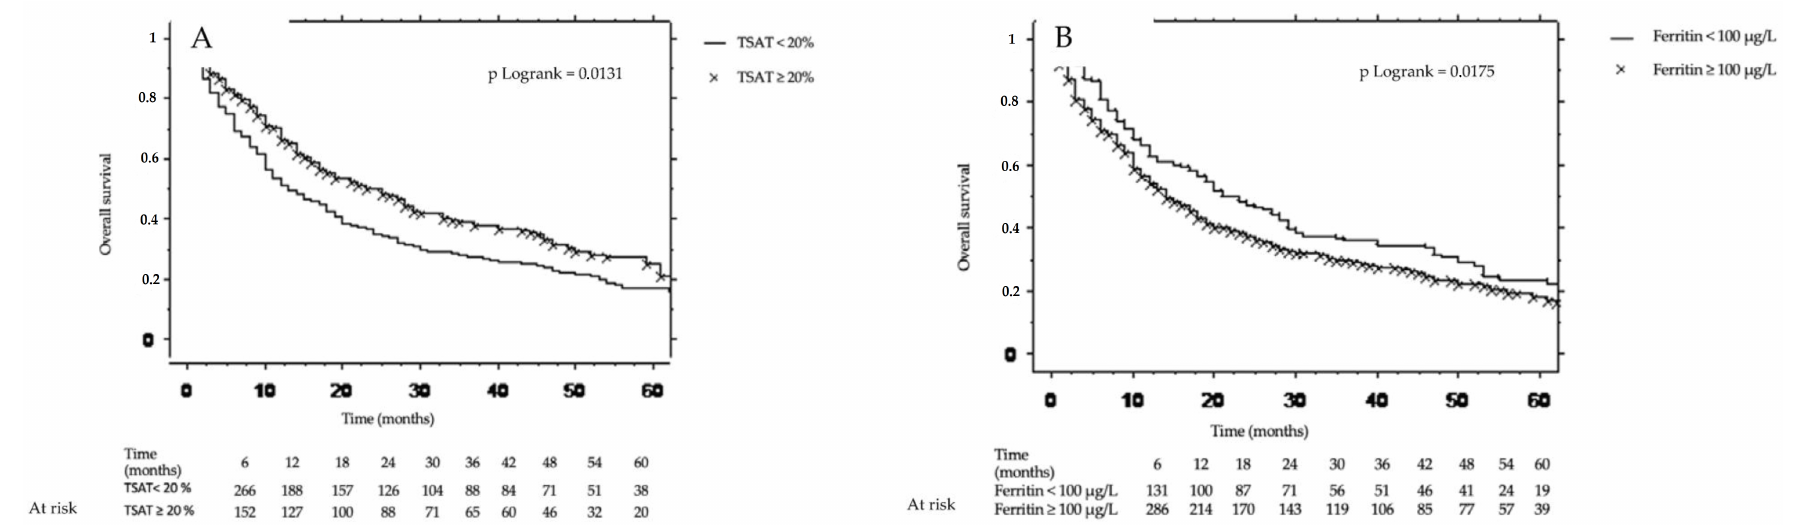
Figure 2. Kaplan–Meier curves according to transferrin saturation < 20% ( A ) and ferritin < 100 µ g/L ( B